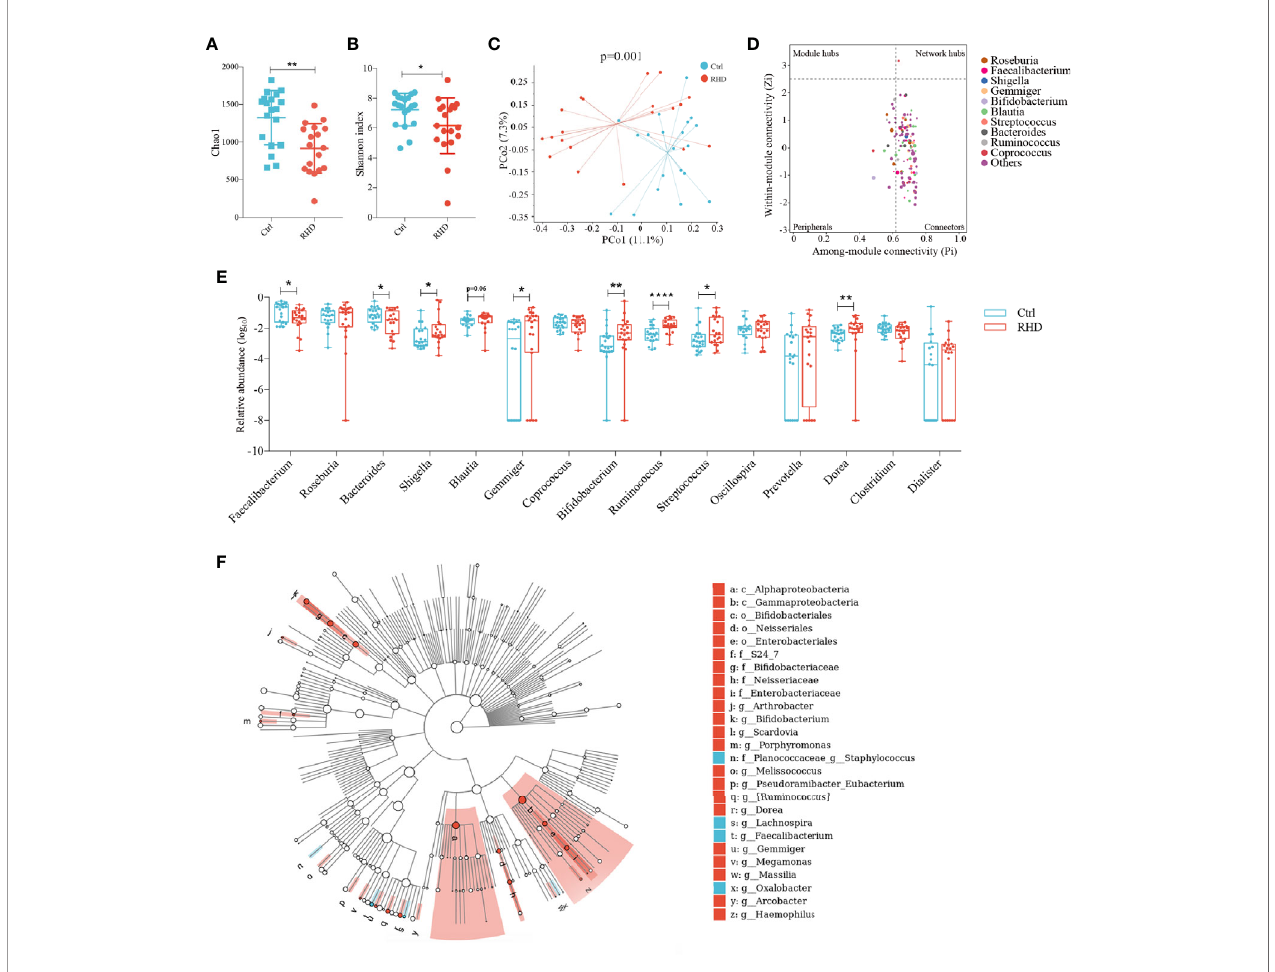
FIGURE 1 | Alterations of gut microbiota in patients with rheumatic heart disease. Microbiota of fecal samples from patients with rheumatic heart disease (RHD) and control subjects (Ctrl) were analyzed using 16S rRNA gene sequencing. (A) Richness of fecal microbiota assessed by Chao1. (B) a -diversity of fecal microbiota assessed by Shannon index. (C) b -diversity analyzed by principal coordinate analysis (PCoA) based on Bray – Curtis distance of fecal microbiota at genus level. (D) Determination of module-based topological roles (peripherals, connectors, module hubs, or network hubs) of fecal microbiota in RHD patients using ZP-plot at genus level. The size of dots represents abundance of each genus. (E) Relative abundances of the fi fteen most abundant genera in fecal microbiota. (F) Taxonomic cladogram of fecal microbiota based on LEfSe. Red color indicates increase and blue indicates decrease of taxa in RHD compared to Ctrl. LDA = 3. Mann – Whitney test was used. n = 20: 20. *P < 0.05; **P < 0.01; ****P <